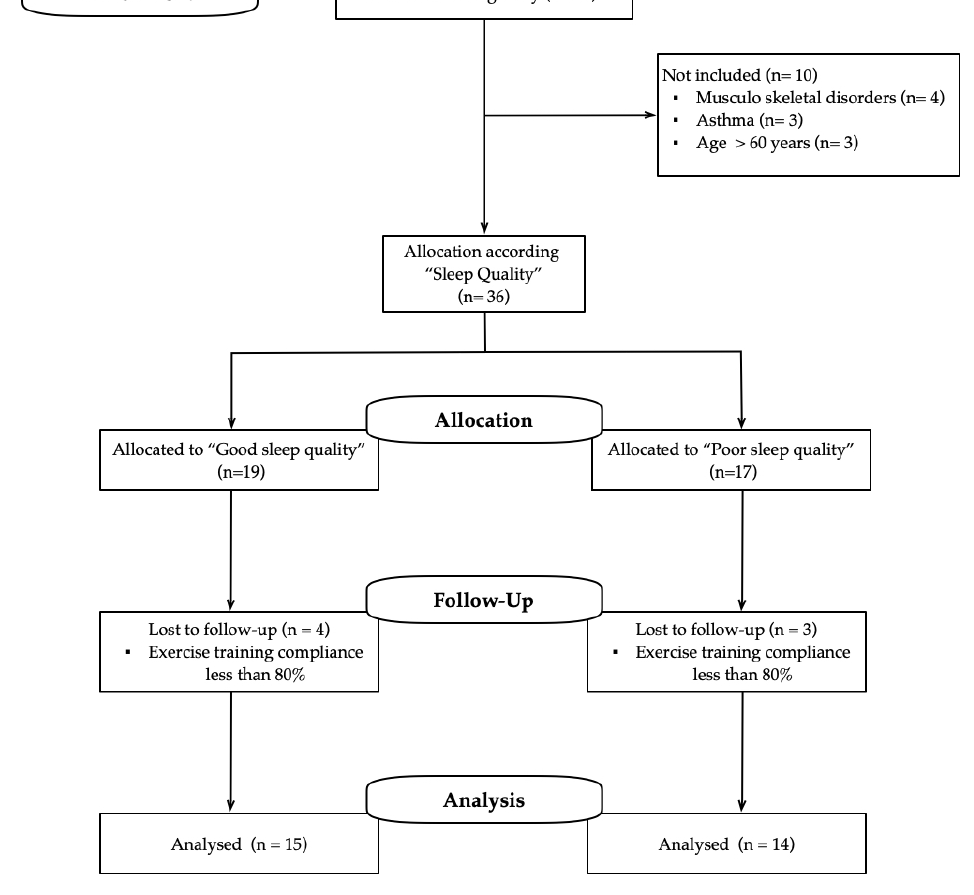
Figure 1. Study design.